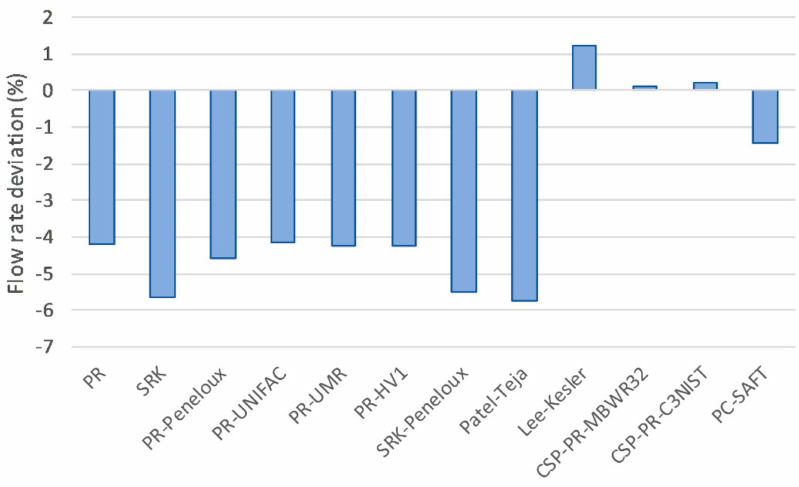
Figure 4. Di ff erence in optimized working fluid flowrate relative to